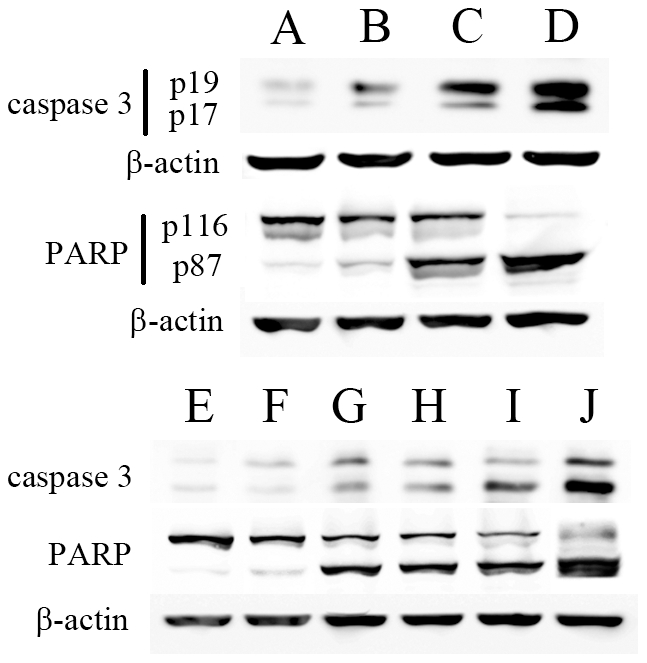
Effect of different treatments on apoptotic cascade.KTC-1 cells were left untreated as controls (A), or treated with 20 MBq/ml 131I (B), 5 µmol/L Bay 11-7082 (C) or combination (D) for 24 hours. Then whole cell lysates were examined by Western blot for caspase 3 and PARP. In the second set of experiments, KTC-1 cells were treated with no oligonucleotide control (E), scrambled oligonucleotides (F) or p65 siRNA transfection (G) first. Then these three groups of cells were exposed to 131I (20 MBq/ml) for 24 hours (H–J). Caspase 3 and PARP protein levels were examined by Western blot. β-actin was used as a loading control. Similar results were obtained in three independent experiments.